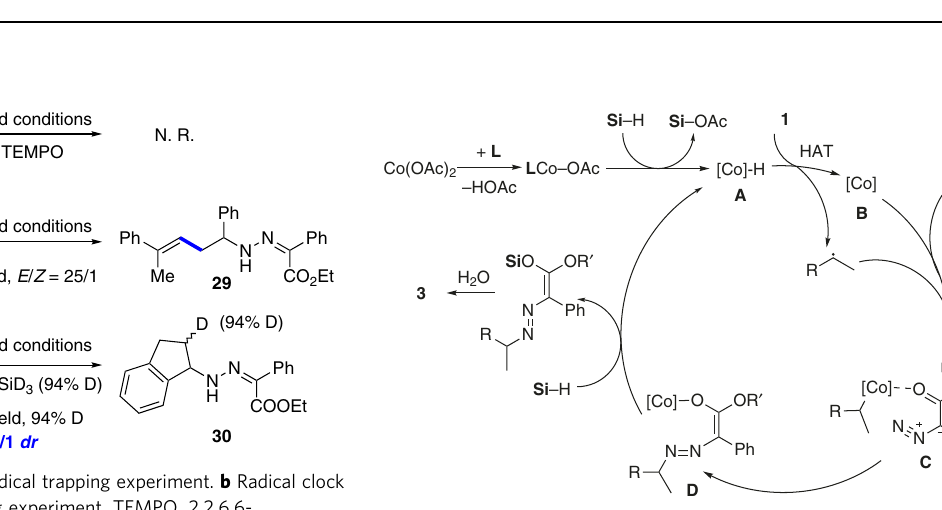
radicals that rebind to cobalt followed by attack on diazo compound and formation of C – N